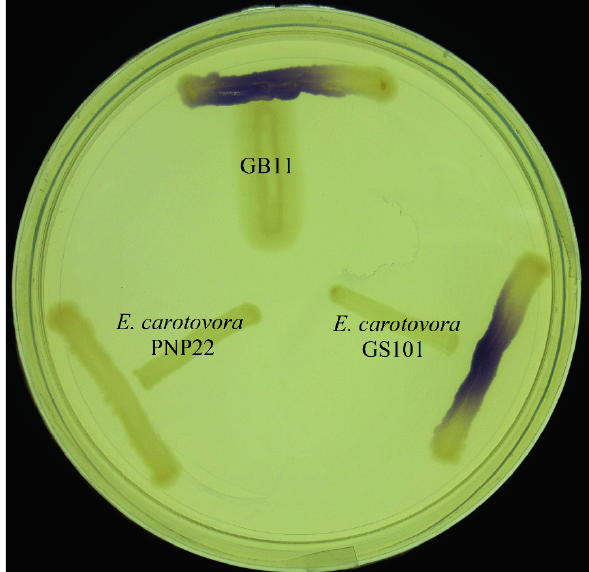
Figure 1. Detection of AHL by C. violaceum CV026. Purple pigmentation was visible after 24 h of incubation as the AHLs produced by the isolate GB11 diffused through the agar and activated the biosensor strain. E. carotovora GS101 and E. carotovora PNP22 were included as positive and negative controls,